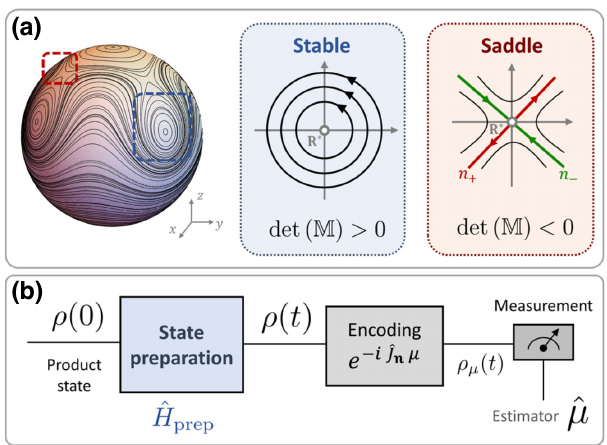
FIG. 1. (a) Phase-space portrait of the classical motion of a collective spin system. Prominent phase-space structures include stable orbits and saddle points. (b) Interferometric approach to quantum metrology with collective spins. A product state ρ( 0 ) undergoes a state preparation procedure to yield the probe state ρ( t ) , which is then used to sense an unknown parameter μ